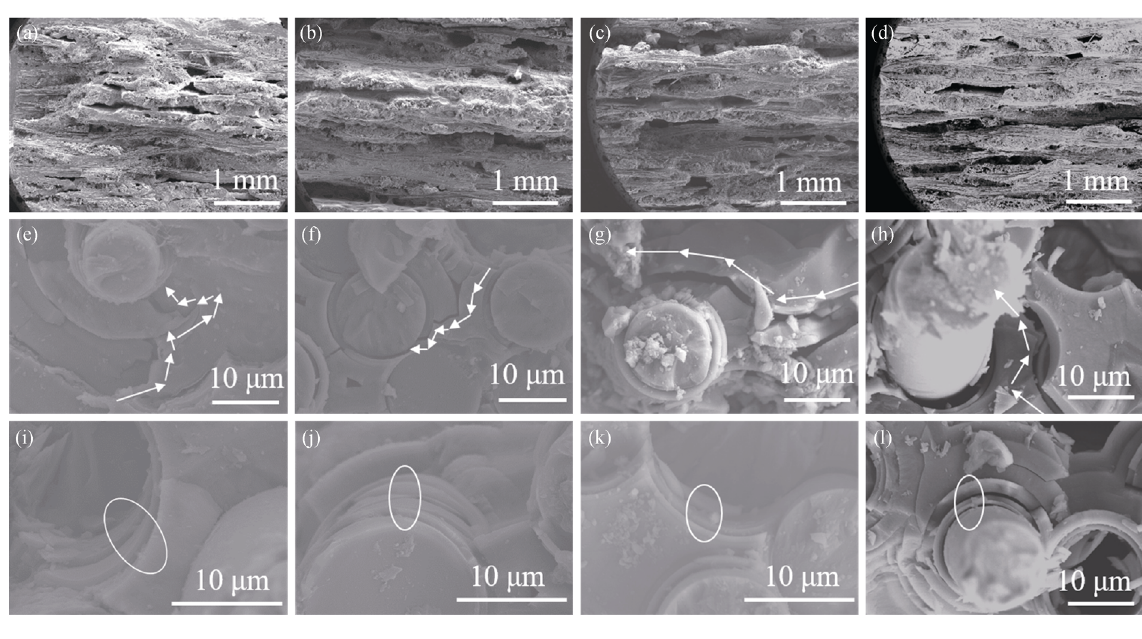
Fig. 4 Fracture morphologies of as-fabricated composites after three-point bending test: (a, e, and i) SiC f /SiC, (b, f, and j) 1#, (c, g, and k) 2#, and (d, h, and l) 3#.